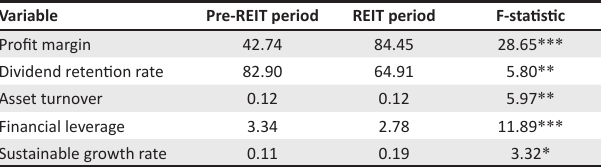
TABLE 3: Mean differences between the pre-real estate investment trust and real estate investment trust period.